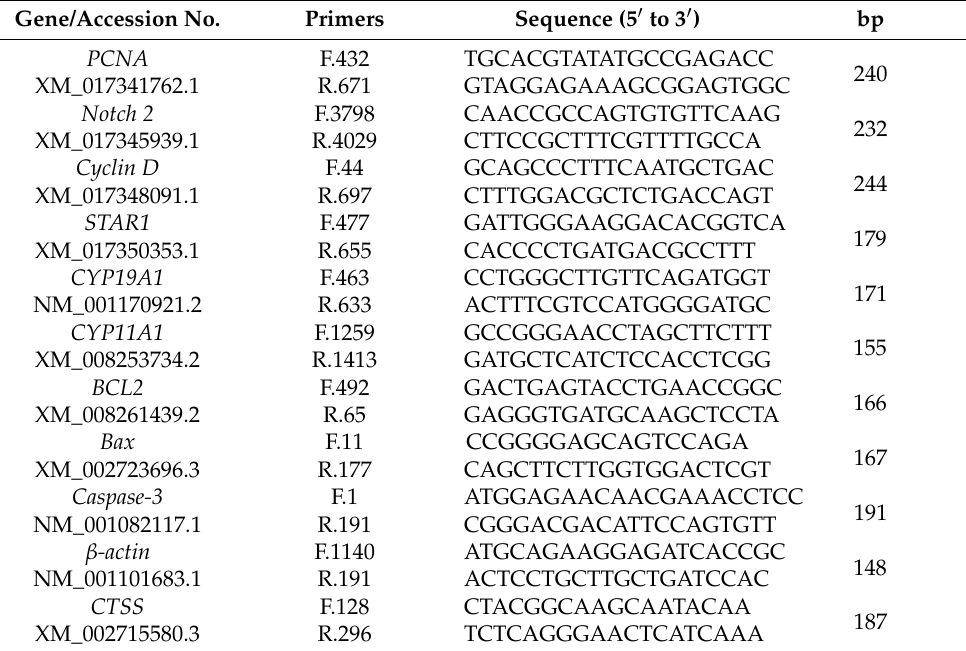
Table 1. Name, accession number, sequences, amplicon length of primer pairs of